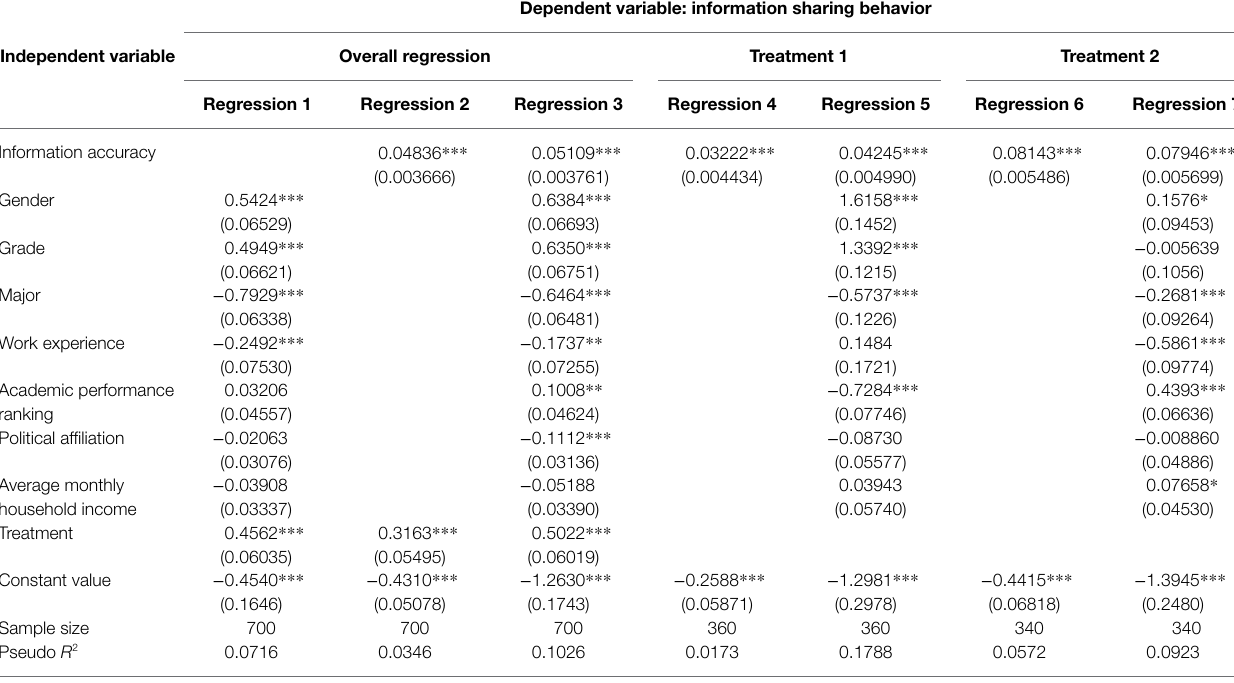
TABLE 3 | Information accuracy and information sharing behavior.